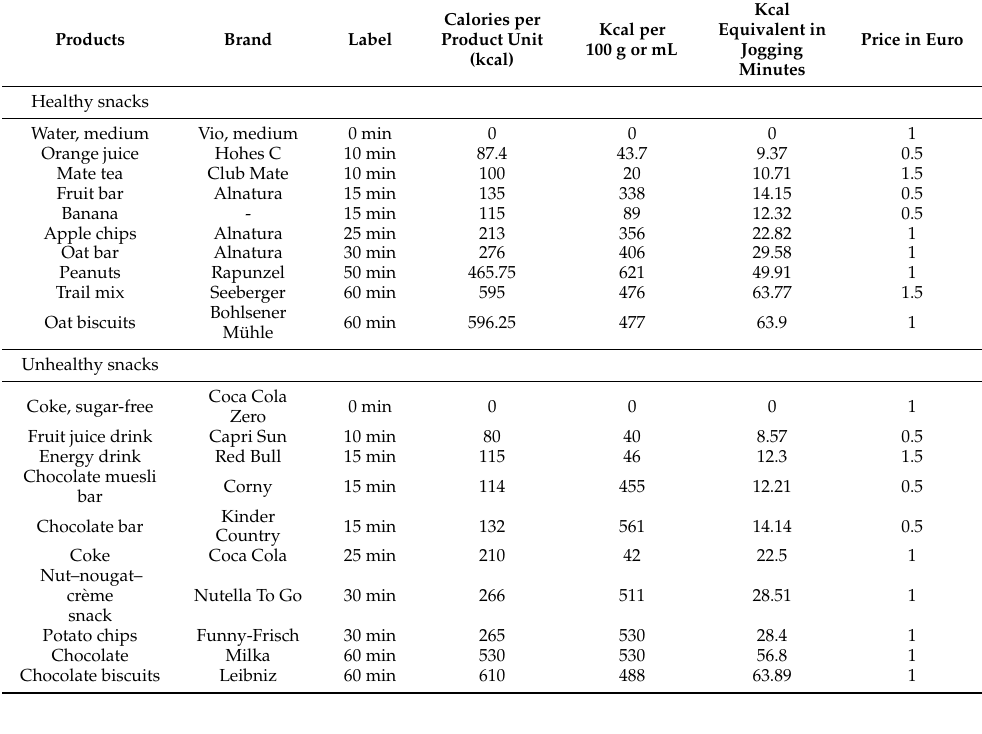
Table 1. List of products with their calorie contents, equivalent values in jogging units, and the product price. The order of the products within the two groups (healthy vs. unhealthy) depicts the pairs described.